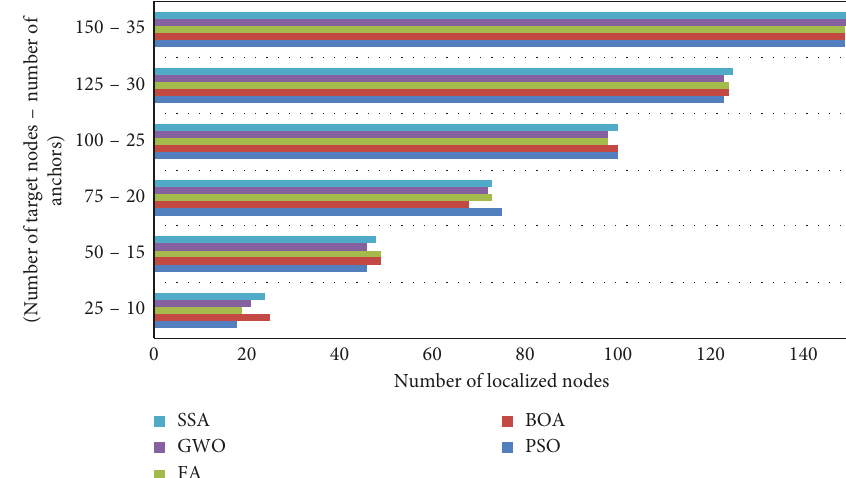
Figure 6: The number of localized nodes of the different localization algorithms in different WSN